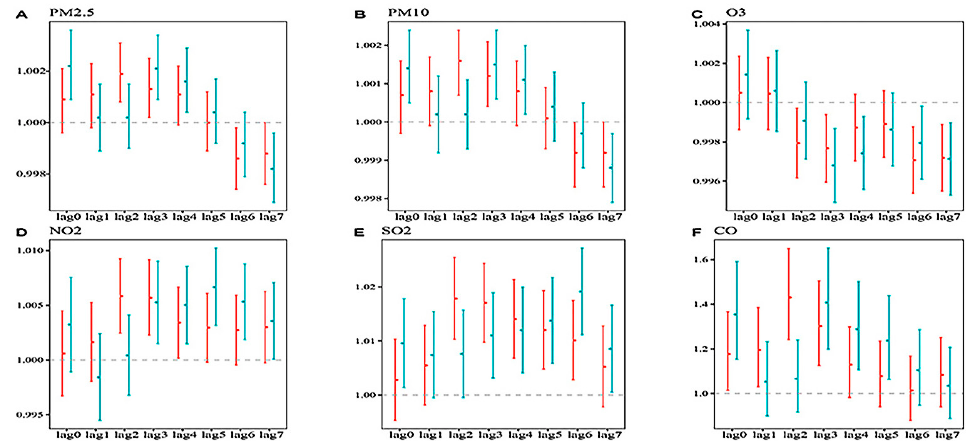
Figure 3. Percent changes and estimated relative risks (RRs) of different sexes for a 1 µ g/m 3 (CO concentration: 1 mg/m 3 ) increase of pollutant concentrations at lag 0–lag 7 during 2020–2021. Notes: the red color indicates male results; the green color indicates female results.